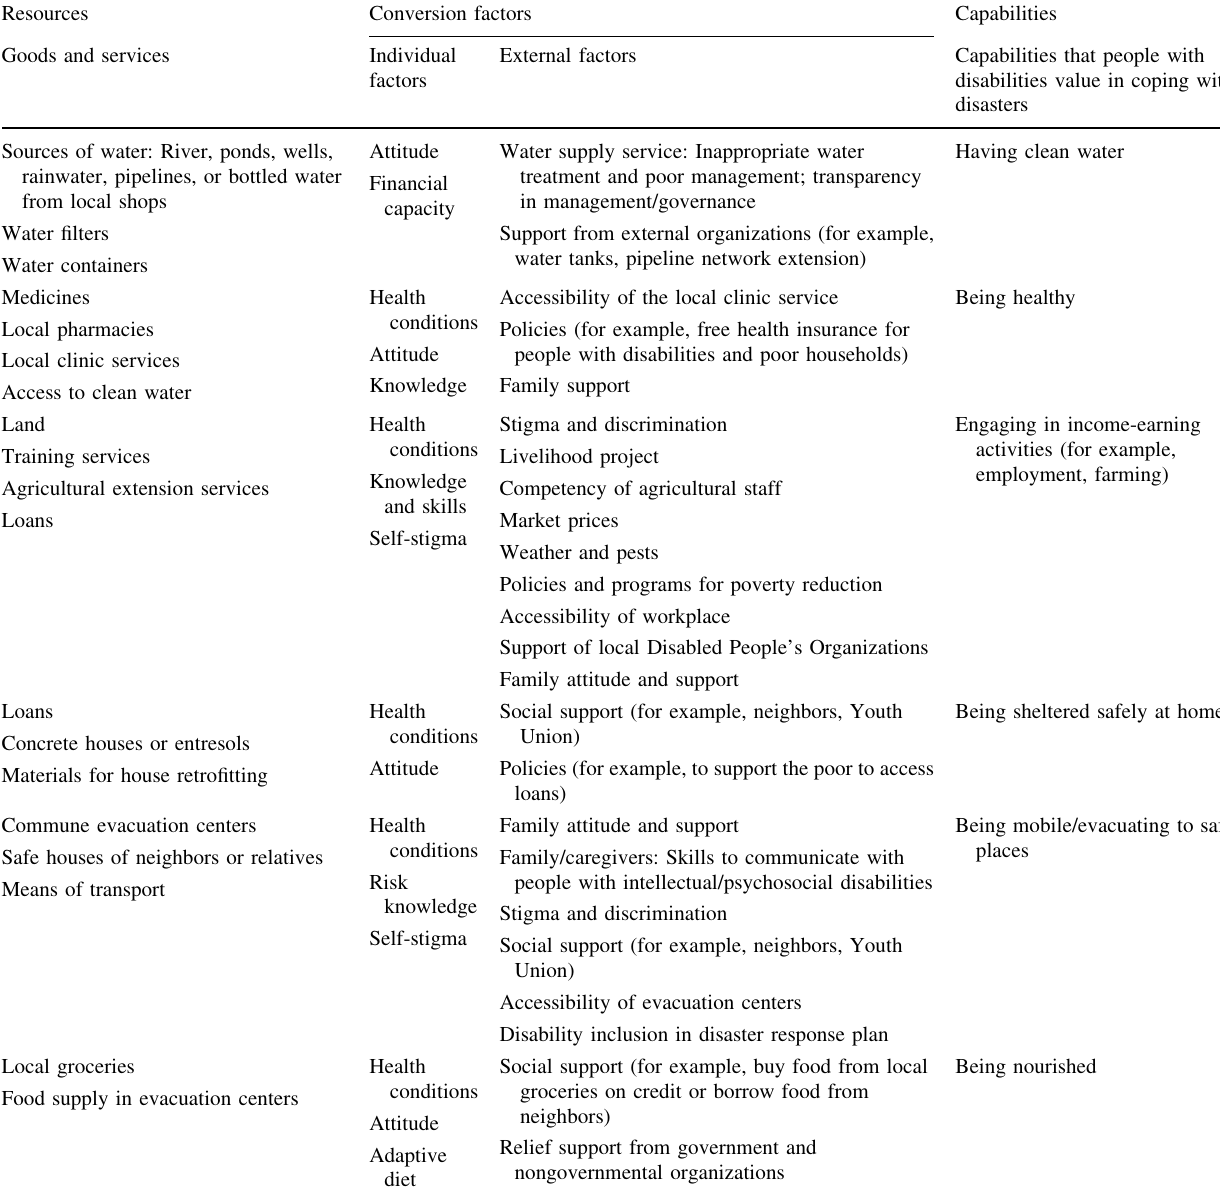
Table 2 Main capabilities to reduce the impacts of disasters valued by people with disabilities in Cam Thuy and Phu Luong Communes, Vietnam. Source: Interviews and focus group discussions (FGDs) in